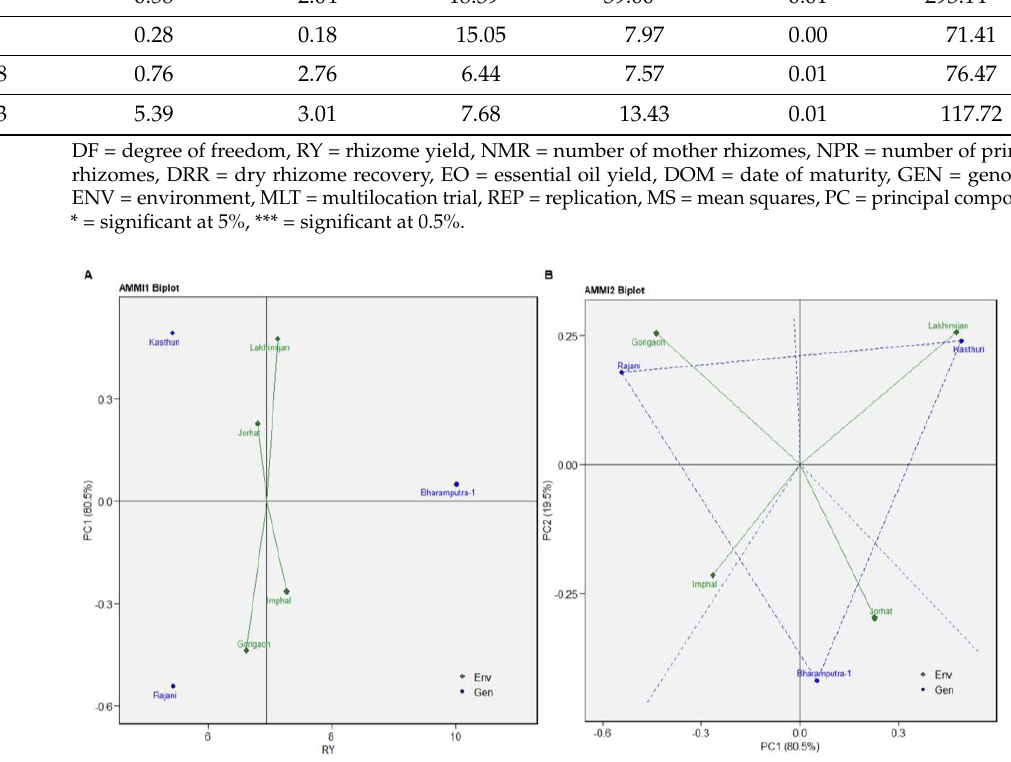
Figure 2. ( A ) AMMI1 biplot ( B ) AMMI2 biplot for rhizome yield. All the selected genotypes were placed in the vertices of the AMMI2 biplot triangle of both RY and NPR, indicating the best suitable genotype for that particular location [33]. The favorable genotype suited for the locations Imphal and Jorhat is Bharampu- tra-1, while Rajani and Kasthuri demonstrated high rhizome yield and number of pri-